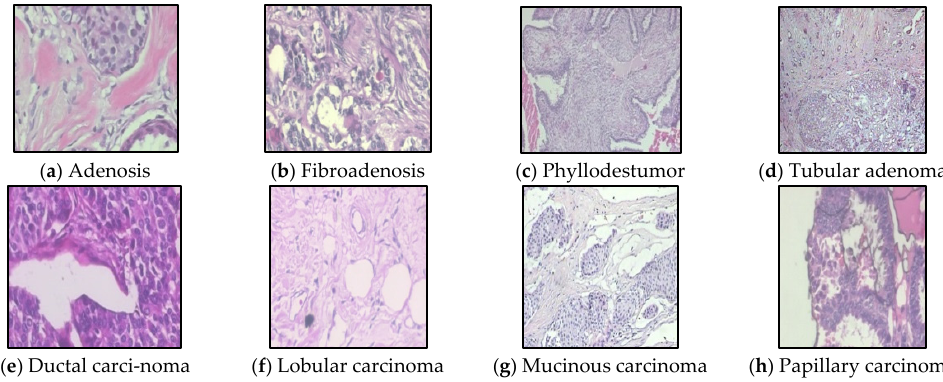
Figure 6. Breast cancer histopathology images from the BreakHis dataset.